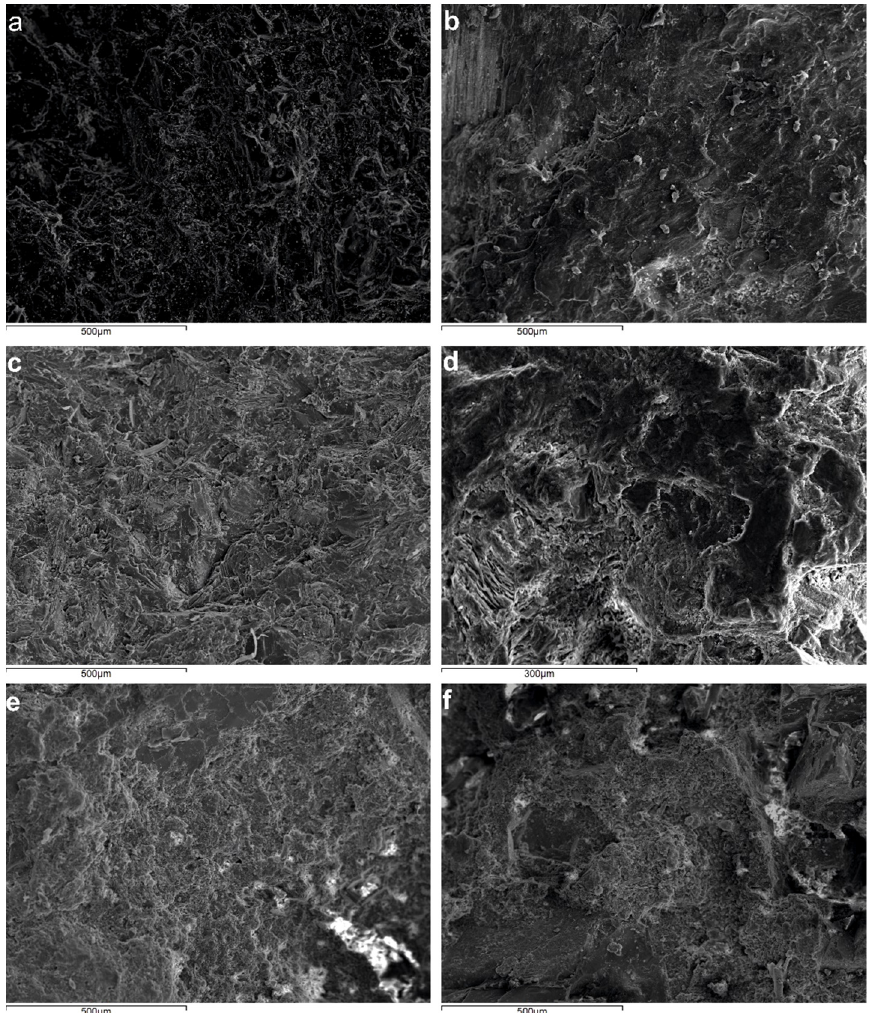
Figure 4. Secondary electron images (SEI) showing the surface texture of representative studied rocks. Differences in the mineralogical and textural features are also observed: ( a ) serpentinized Lherzolite (sample BE.103); ( b ) serpentinized Lherzolite (sample GE.42); ( c ) diabase (sample KIL.2); ( d ) metamorphic Gabbro (sample ED.26); ( e ) andesite (sample BE.101); ( f ) dacite (sample GE.23).